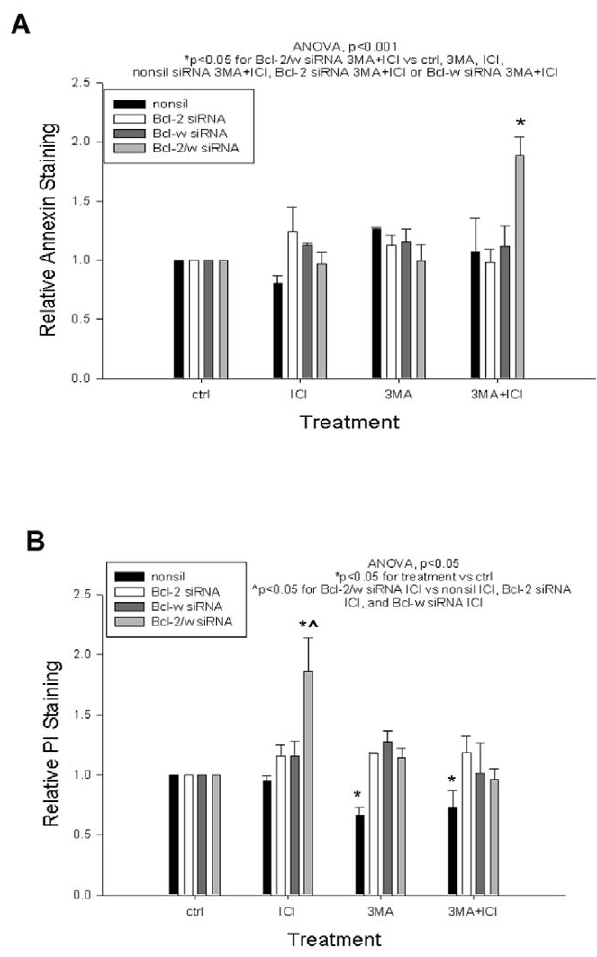
Figure 5. BCL-W/BCL2 knockdown and autophagy inhibition increases apoptosis and decreases necrosis. ( A ) MCF-7/LCC9 cells were transfected with a combination of BCL-W and BCL2 siRNA and treated with ICI and 3MA. Bars represent the mean 6 SE of the relative Annexin V staining (normalized to empty vector controls) for three independent experiments. ( B ) Bars represent the mean 6 SE of the relative PI staining (normalized to empty vector controls) for three independent